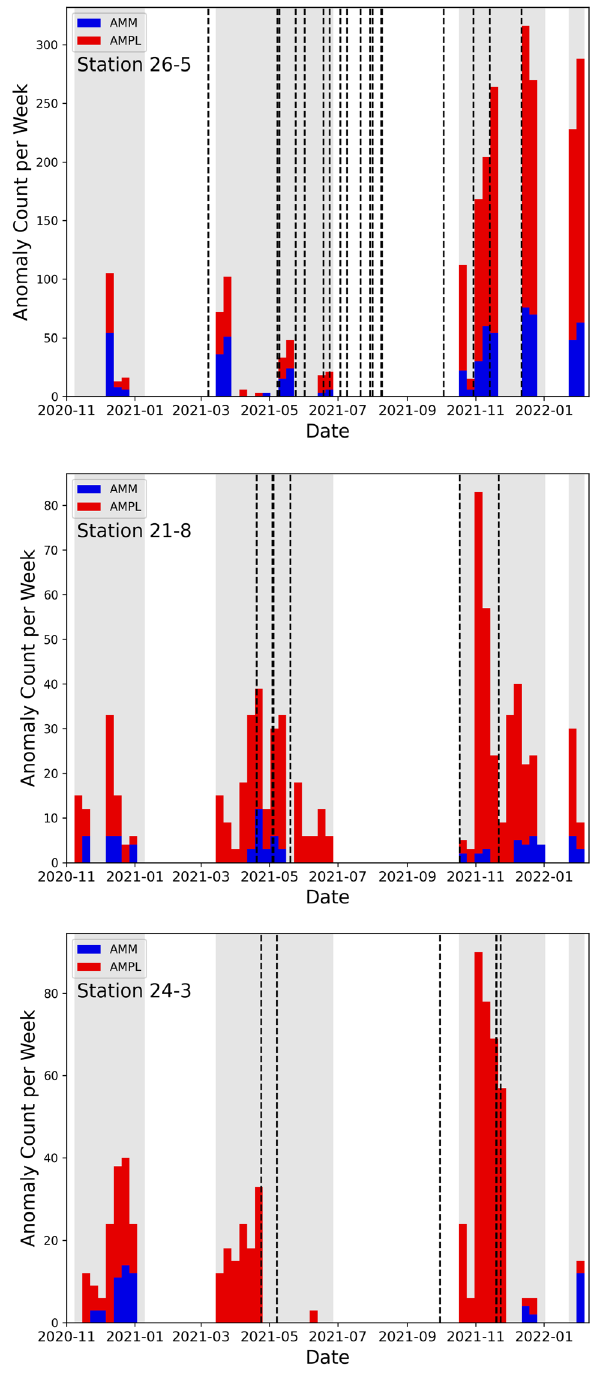
FIG. 7. Count of the number of anomalies detected by AMPL (red bars), the AMM bit (blue bars), and problems reported in CATER (black dashed lines) for various stations. The anomaly counts have been binned by week to produce the histograms. The shaded regions show weeks where the BPM data were available through the BSA service. Top: station 26-5. For this station, both the AMPL and AMM bit signals detect anomalies at approx- imately the same time. Middle: station 21-8. AMPL detects anomalous activity more often than the AMM bit does. Bottom: station 24-3. AMPL detects anomalous activity in April and November 2021 that the AMM bit misses